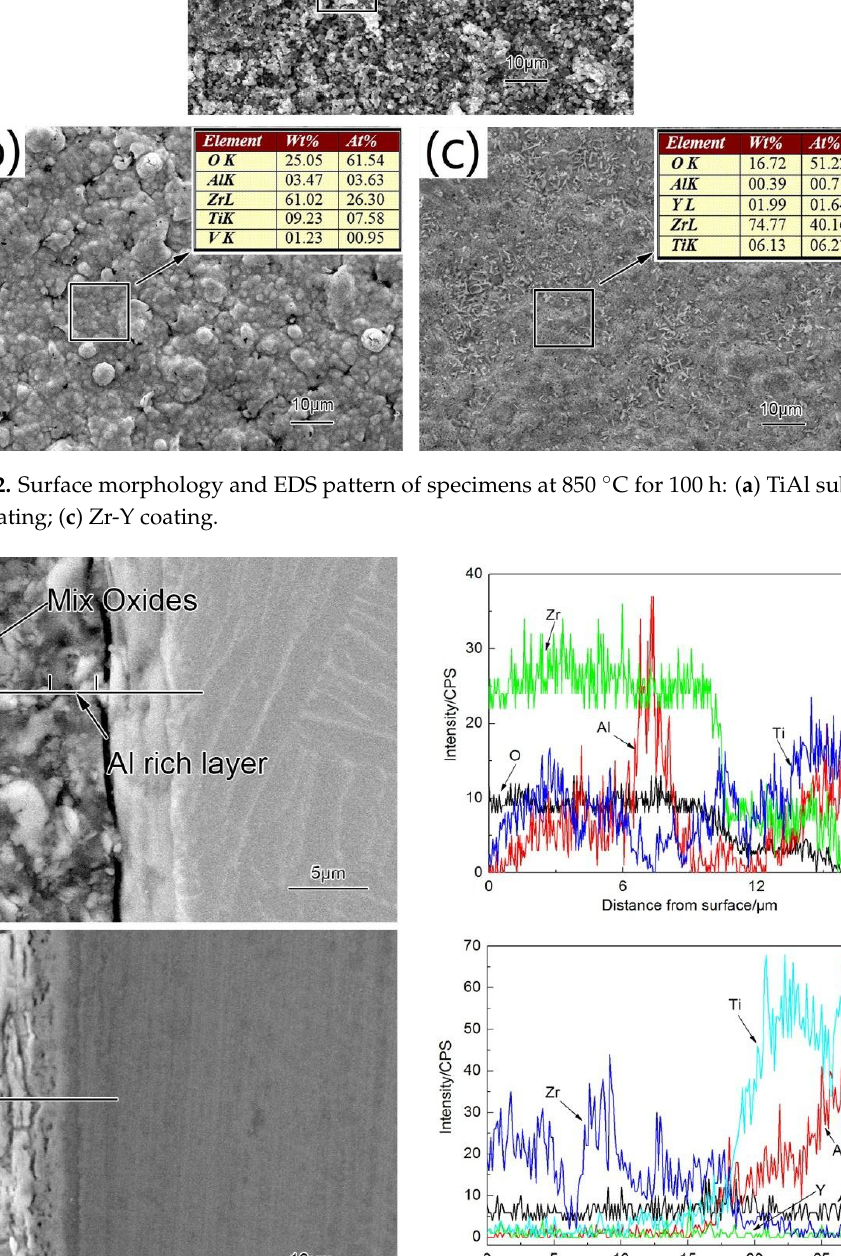
Figure 13. Cross-sectional morphologies and compositions of the specimens at 850 °C for 100 h: ( a ) Zr coating; ( b ) Zr-Y coating. ( a ) Zr coating; ( b ) Zr-Y